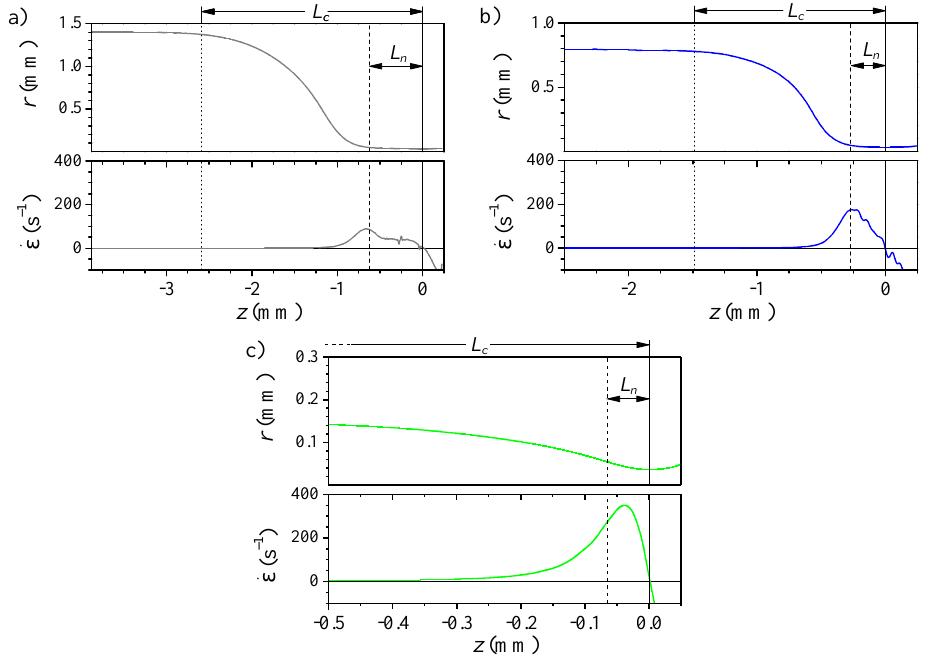
Figure 5. Shape and strain rate along the nozzle axis for nozzles 2 ( a ), 6 ( b ) and 8 ( c ) and Q = 5 µ L/min. The vertical lines indicate sections of diameter D , i.e., the neck, (solid), 1.5 × D (dashed), 0.98 × ID (dotted). The latter is out of the field in ( c ).